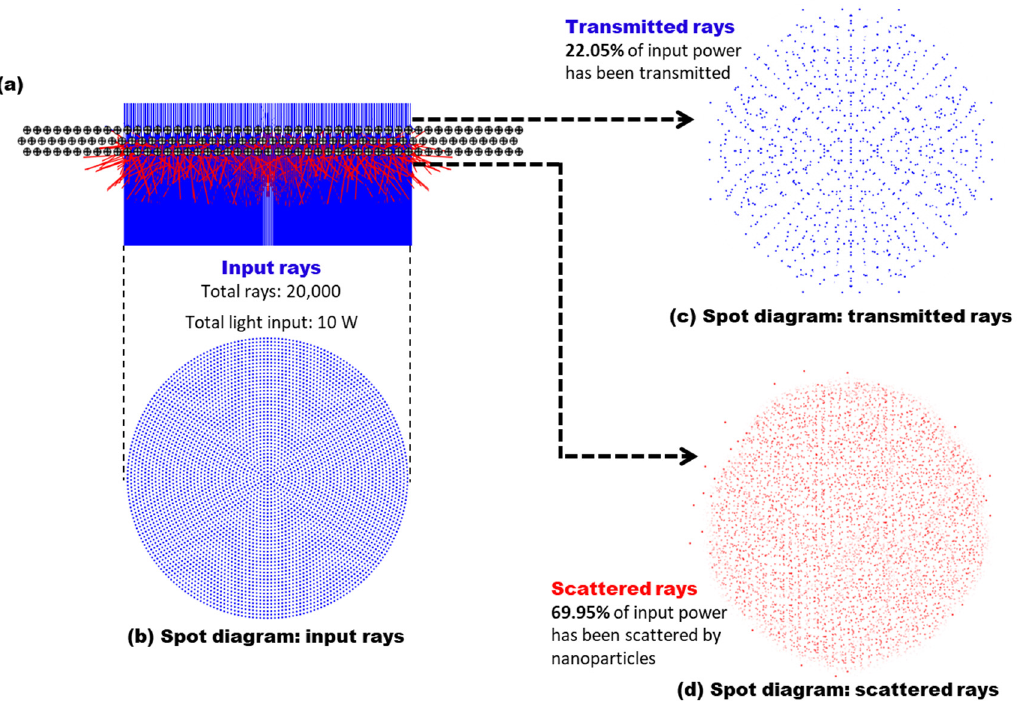
Figure 3. Plasmonic light scattering by an array of metallic nanoparticles. ( a ) A cross-sectional view shows three staggered layers of uniformly distributed conductive nanoparticles. Each nanoparticle has a diameter of 50 nm. Within each layer, the nanoparticles are uniformly distributed 20 nm apart from each other. The three layers are arranged in a staggered manner, separated by a vertical height of 25 nm. Spot diagrams of ( b ) the input rays modelled as a circular beam with a total of 20,000 input light rays projected from the bottom onto the nanoparticle arrays, ( c ) the transmitted rays emerged from the top of the nanoparticle arrays, and ( d ) the scattered rays emerged from the bottom of the nanoparticle arrays. The light rays are scattered at an angular spread upon hitting the nanoparticles. Only 22.05% of the input power emerged from the top layer as transmitted rays, while the scattered rays emerged from the bottom of the nanoparticle arrays at 69.95% of the input power. From the perspective of a FEOET device, the addition of a metallic nanoparticle layer above the low-quality TiOPc layer causes plasmonic light scattering to redirect additional rays onto the TiOPc layer, greatly enhancing its light absorption and photo-state conductivity.